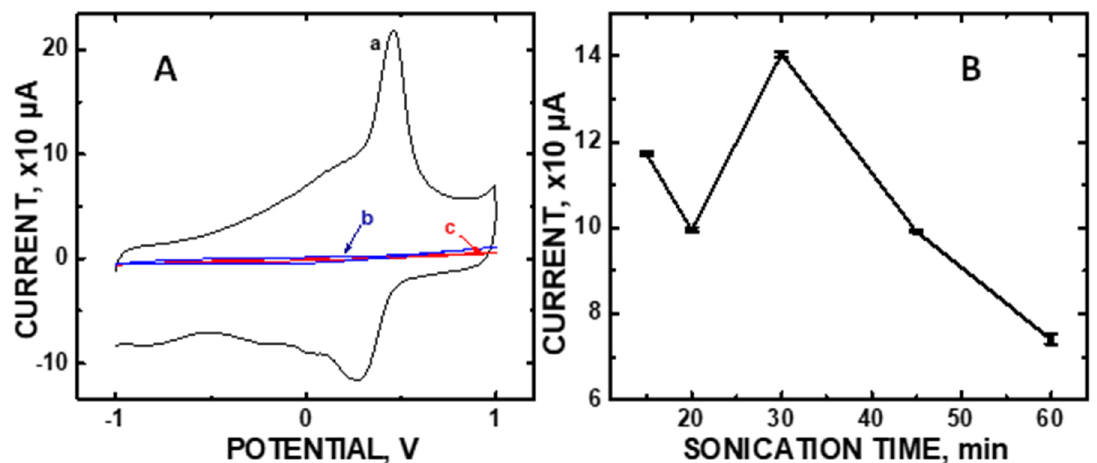
Figure 1. ( A ) Cyclic voltammetries (CVs) of 100 µM concentrations of ( a ) dopamine (DA), ( b ) ascorbic acid (AA), and ( c ) uric acid (UA) using the Nafion/CoO/.COOH-MWNT/GCE at pH 5.0 at a scan rate of 50 mV/s; ( B ) CV current at oxidation potential +0.300V vs sonication time (error bars of the data points are smaller than the symbols).